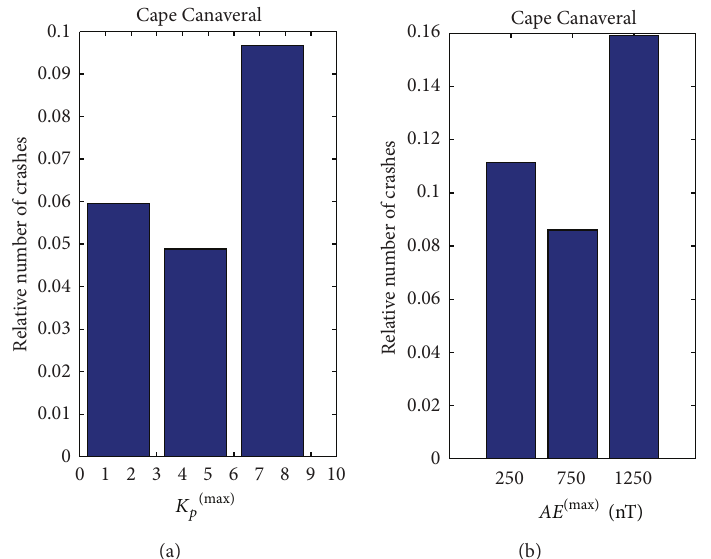
Figure 11: Relative number of crashes for different level of geomagnetic indices 𝐾 𝑝 (a) and 𝐴𝐸 (b) at Cape